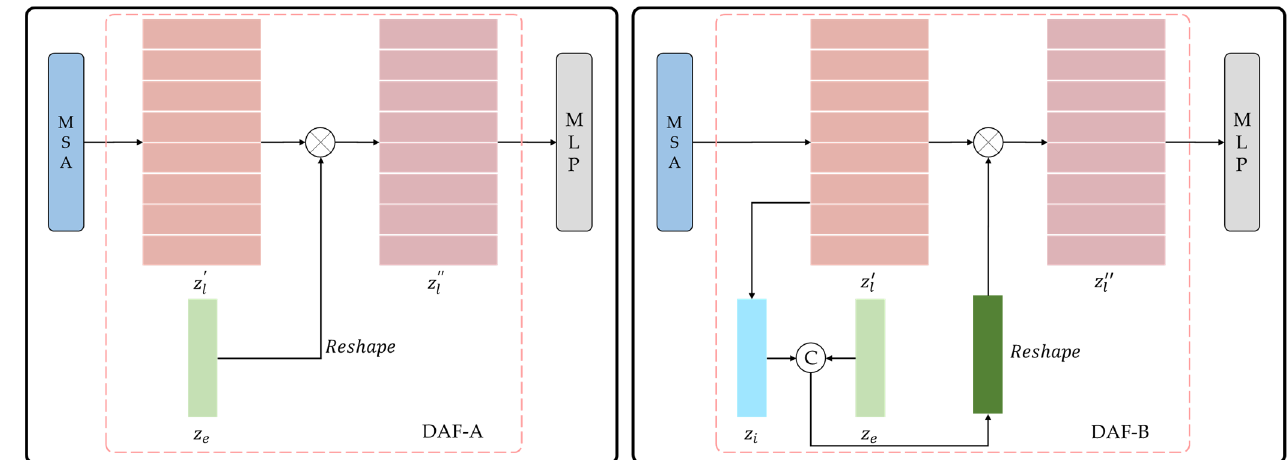
Figure 3. Comparisons between the two versions of the DAF model. DAF-A is the basic version and DAF-B is the concatenated image embedding and multimodal location environment embedding. Finally, z 0 are replaced by the corresponding positions in the LMT, and the patches L with high weights are extracted again for the next iteration. Aerial image embedding and multimodal location environment embedding have the potential to complement each other. Therefore, we concatenated image embedding and multimodal location environment embedding in DAF-B, which is an extended version of DAF-A, and then dynamically mapped them to the image